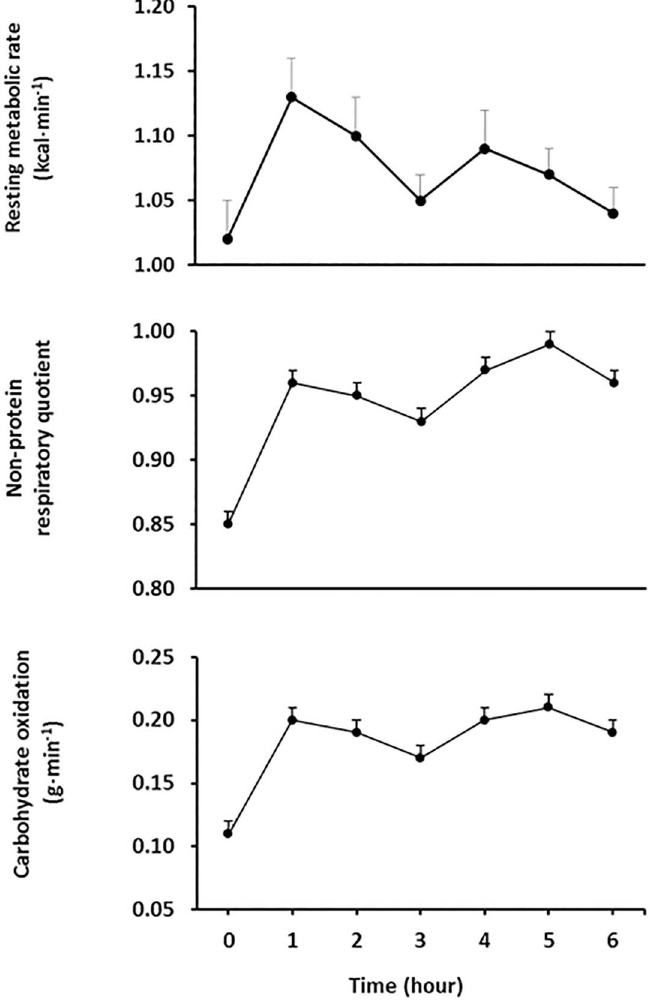
Fig 4. Resting metabolic rate, non-protein respiratory quotient and carbohydrate oxidation before and after two consecutive 75-g oral glucose loads. Glucose loads were given at time 0 and 3 h. Mean ± SE.